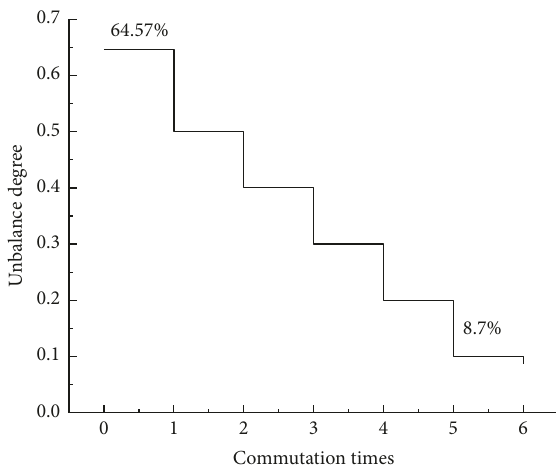
Figure 8: Unbalance rate